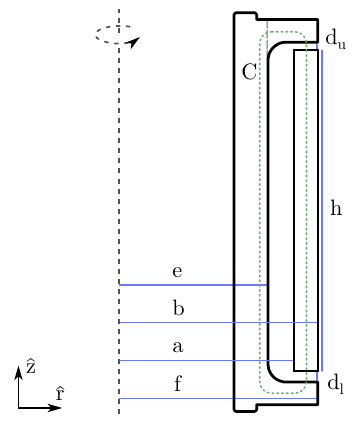
Figure 4. Definition of variables in the rz -plane. Note that the curve C lies in the main flux